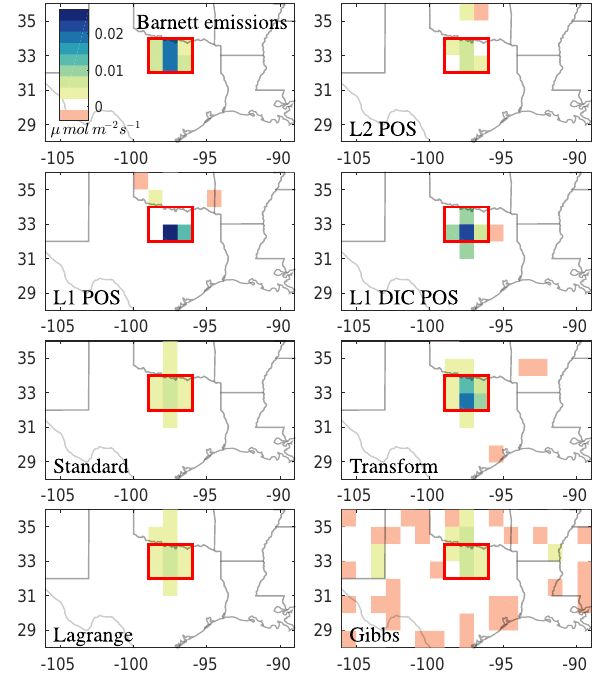
Figure 11. Additional methane sources in the Barnett shale gas reservoir (upper left panel) are added to the EDGAR emissions (see Fig. 3) and noisy data are simulated. Differences to previous recon- structions from simulated EDGAR data are shown for each method. Emissions in the red box are attributed to the